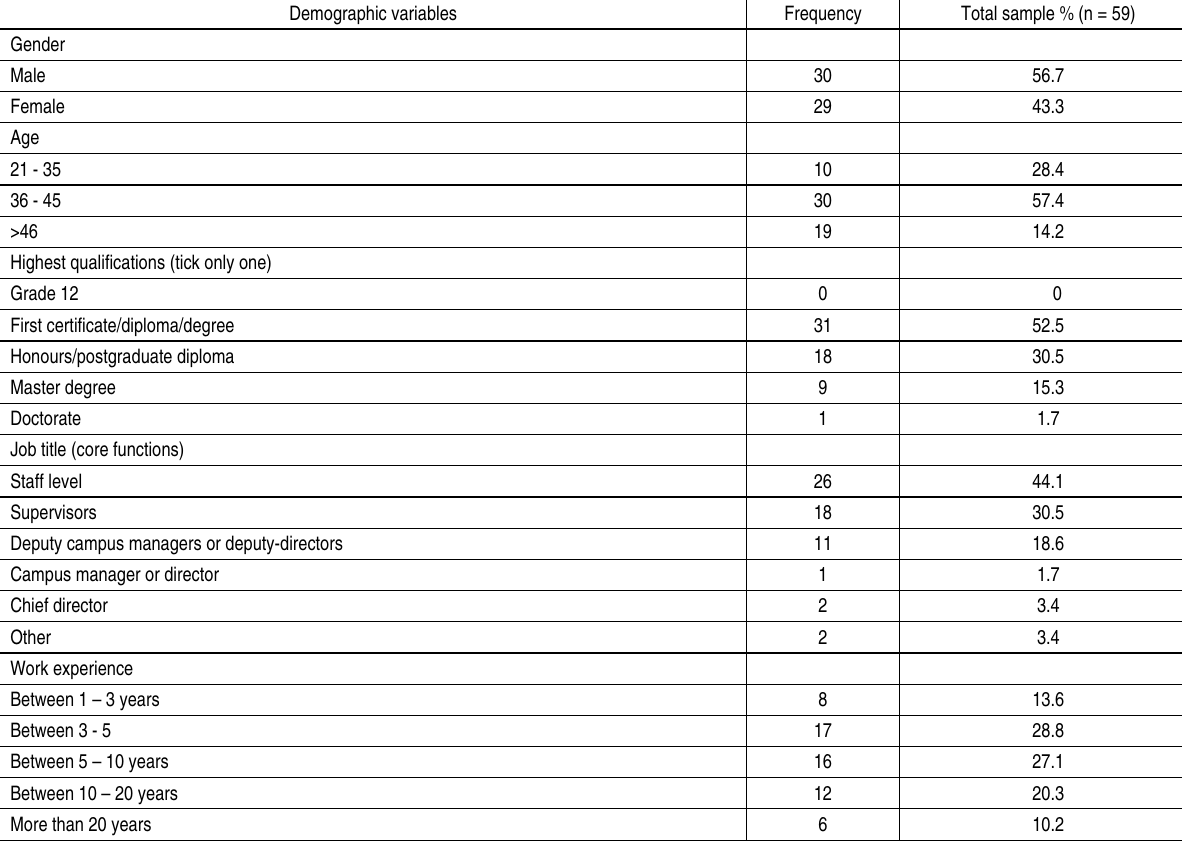
Table 3. Respondents’ demographic